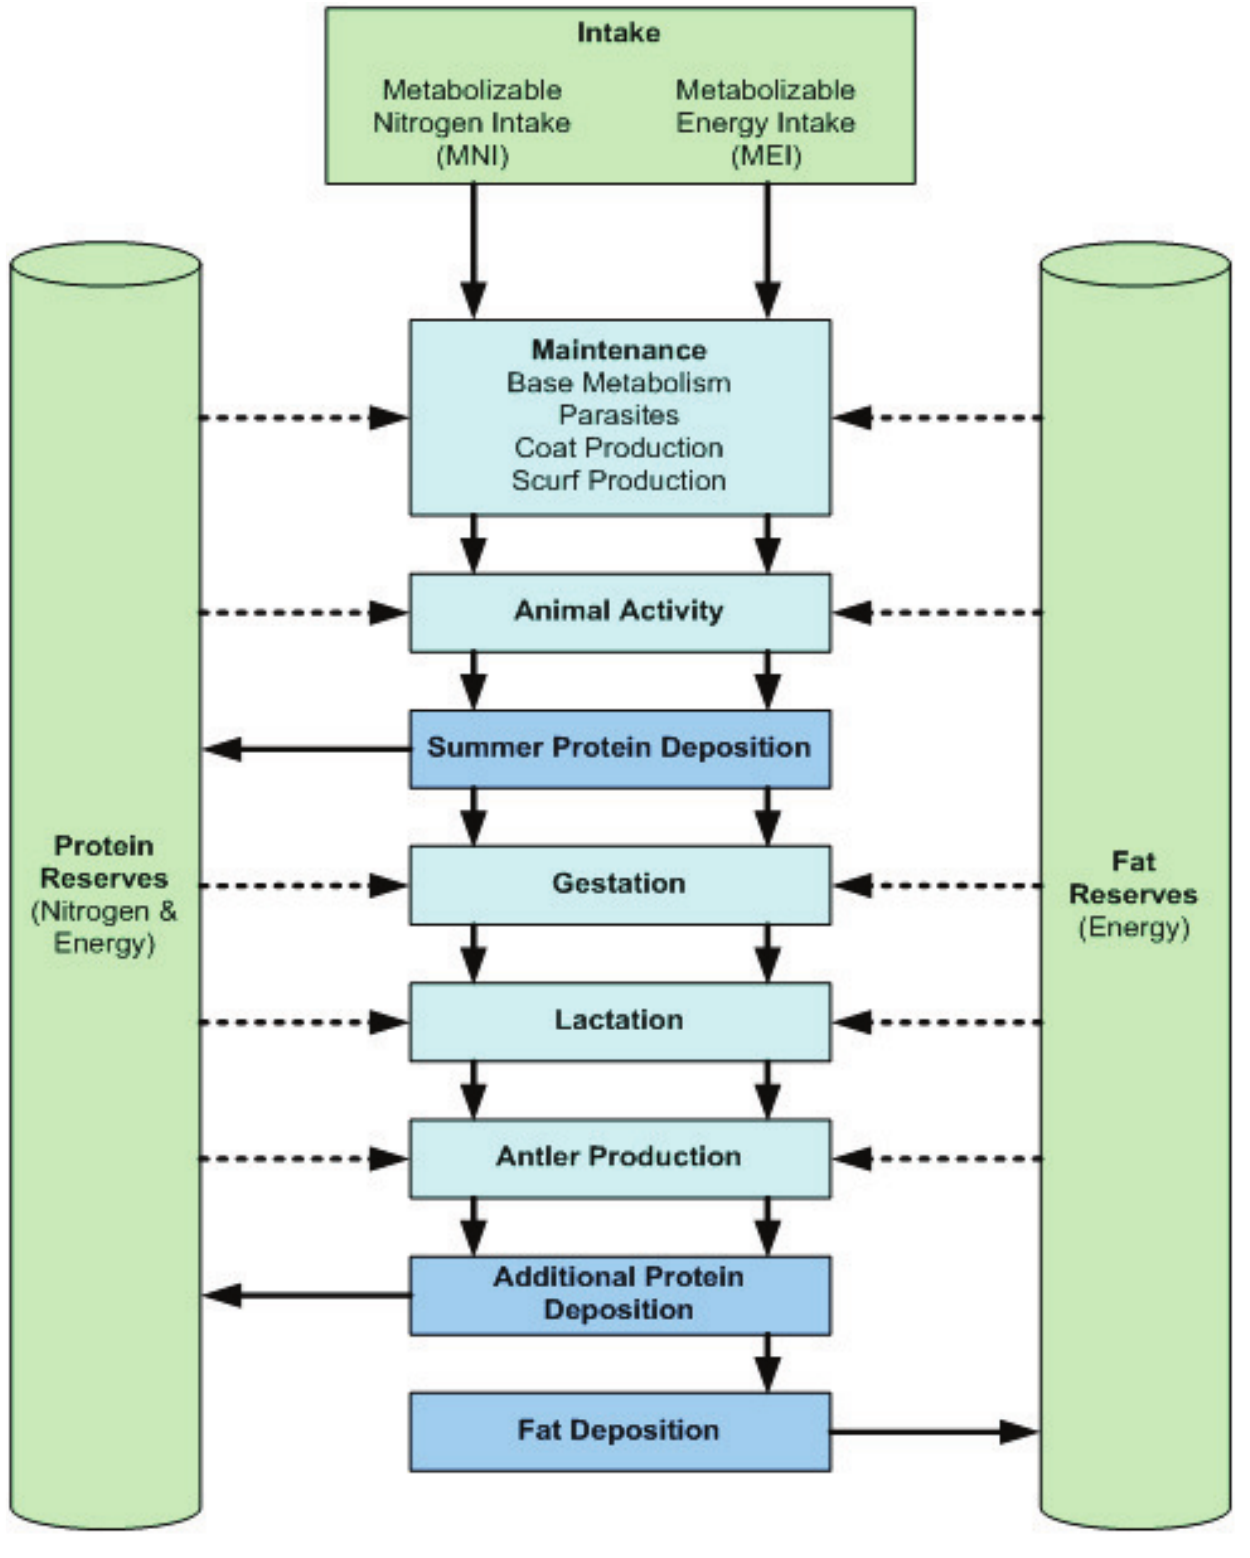
Fig. 1 Daily allocation of protein-N and energy showing the order of priority of each allocation